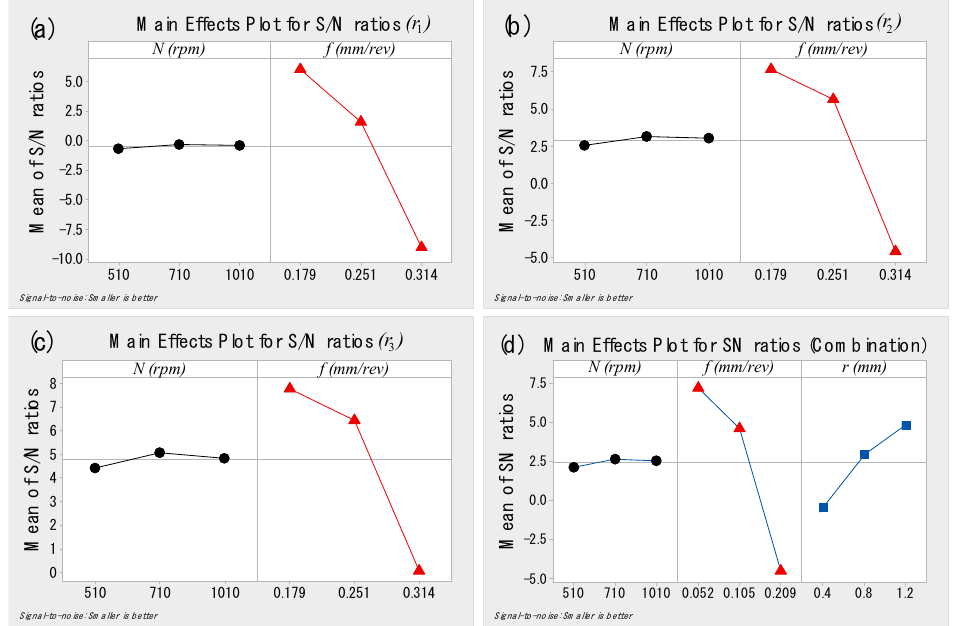
Figure 5. Main effect plot for average S/N ratios versus cutting parameters for surface roughness (R a ) in the following different tool nose radii: ( a ) r 1 , ( b ) r 2 , ( c ) r 3 and ( d ) CNFR. Table 5. S/N ratio response table for surface roughness (R a ) with different tool nose radius ( r ). Tool Nose Radius ( r )